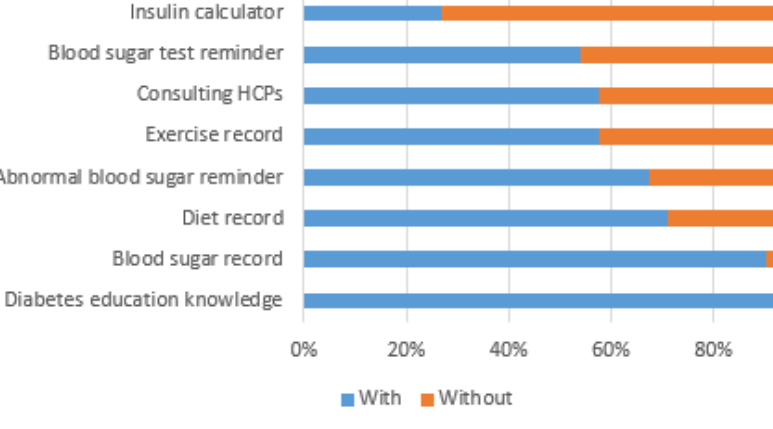
Figure 3. Proportions of different functions of patients’diabetes apps (n=52). HCP: health care professional.